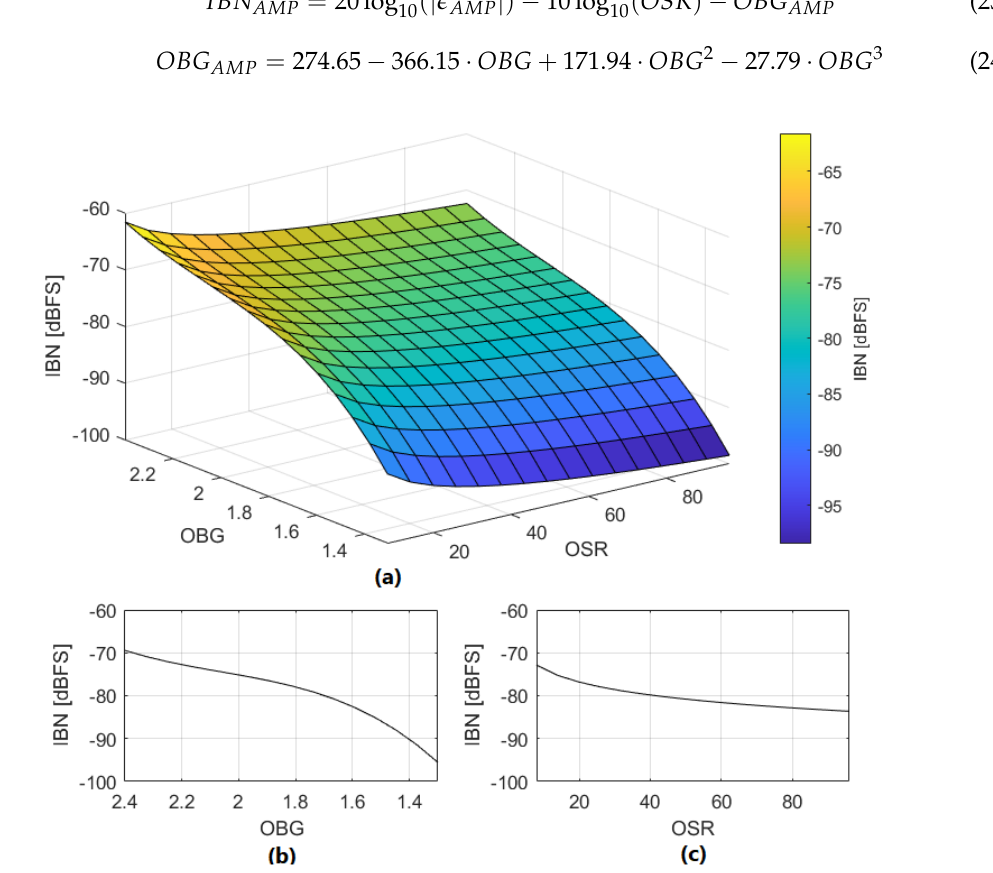
Figure 17. ( a ) IBN AMP dependence on OSR and OBG; | (cid:101) AMP | = 0.003. ( b ) IBN AMP dependence on OBG ( OSR = 64). ( c ) IBN AMP dependence on OSR ( OBG =